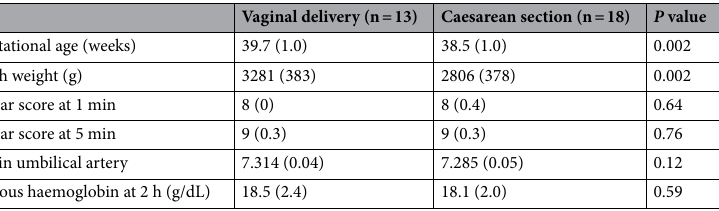
Table 1. Demographic and clinical data of term neonates according to mode of delivery. Data are show as the mean (standard deviation). Neonates delivered by elective caesarean section were significantly lighter than those delivered vaginally because elective caesarean section is performed from a gestational age of 38 weeks in our hospital.